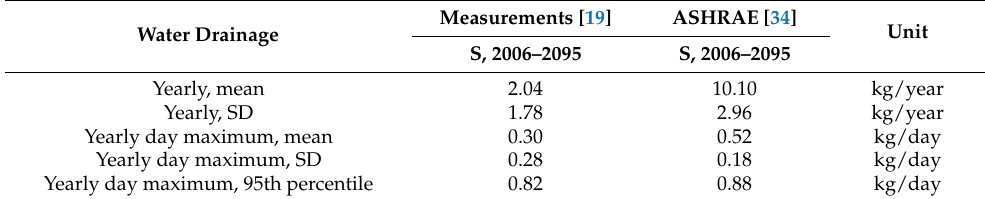
Table 11. Comparing the results using of the assumption of water leakage based on measure- ments [19] to the ASHRAE standard [34]. Simulations for the south facing facade 2006–2095. Water drainage in the joint for all years, present and long-term climate, including mean values, standard deviation and 95th percentile.